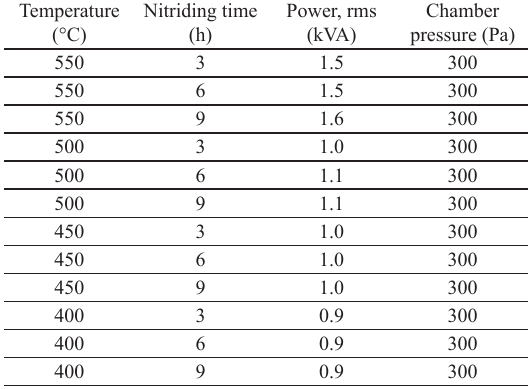
) and 24 vol.% hydrogen (H 2